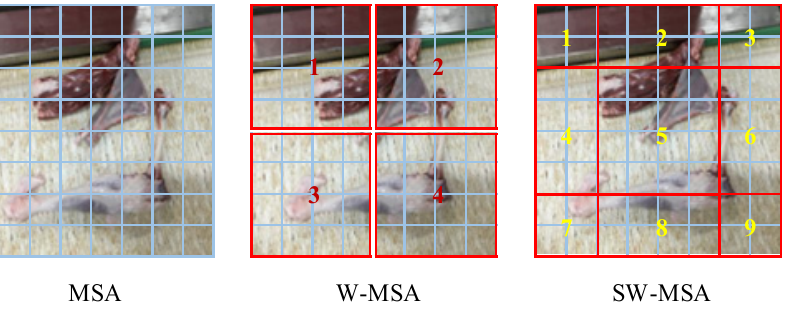
Figure 5. W-MSA and SW-MSA window division. Note: MSA is the multi-head self-attention mechanism. Note: MSA is the Multi-head Self-Attention structure; W-MSA is the Window Multi- head Self-Attention structure; SW-MSA is the Shifted Window Muti-head Self-Attention structure.